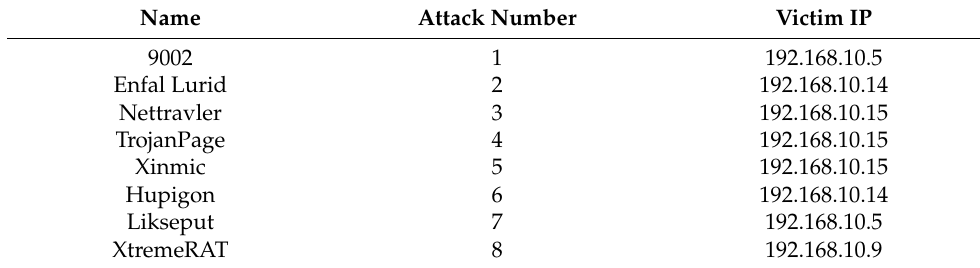
Table 1. IPs of victims in the